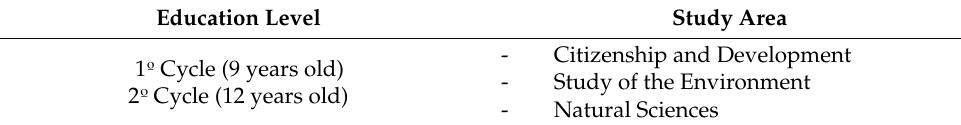
Table 1. Areas where climate change is discussed at school